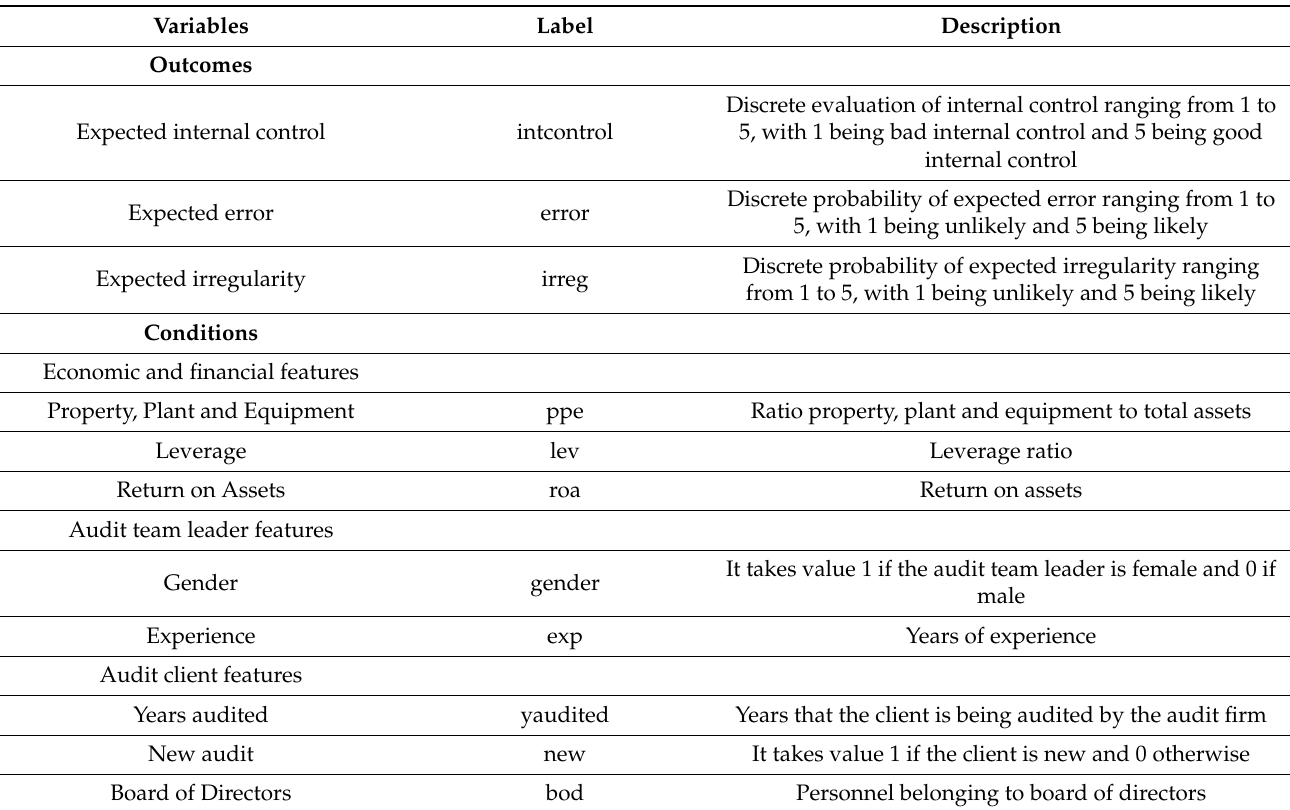
Table 3. Description of outcomes and